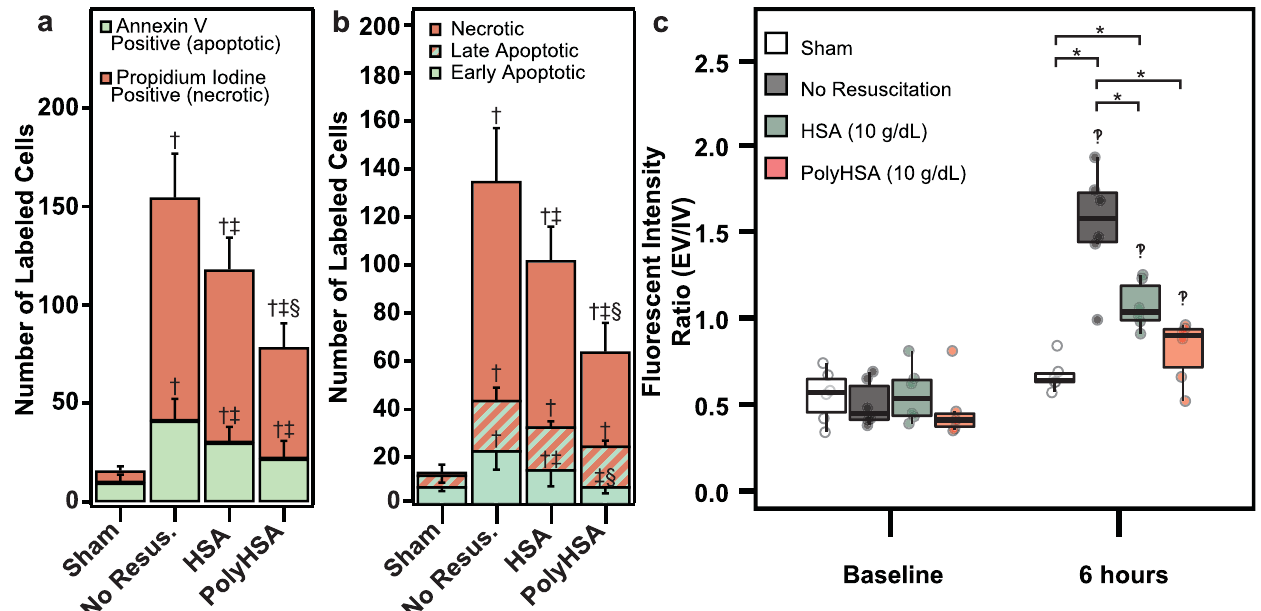
Figure 6. Tissue status following LPS induced endotoxemia. ( a ) Number of annexin V positive and propidium iodine (P.I.) positive stained cells with no resuscitation, infusion of HSA, or infusion of PolyHSA compared to a sham. ( b ) Number of necrotic (PI+/Annexin V−), late apoptotic (PI + /Annexin V +), and early apoptotic (PI−/Annexin V+) cells for each treatment group. ( c ) Endothelial permeability measured via extravascular/ intravascular (EV/IV) fluorescent signals from FITC-Dextran (70 kDa M.W.). A higher ratio indicates more vascular leakage. Data are presented as mean and SD or as boxplots where whiskers indicate 95% CI and boxes indicate data quartiles. † P < 0.05 compared to Sham, ‡ P < 0.05 compared to animals that received no resuscitation, § P < 0.05 compared to animals that received HSA as a resuscitation fluid. *P < 0.05 between groups, ‽ P < 0.05 compared to baseline conditions (n = 6